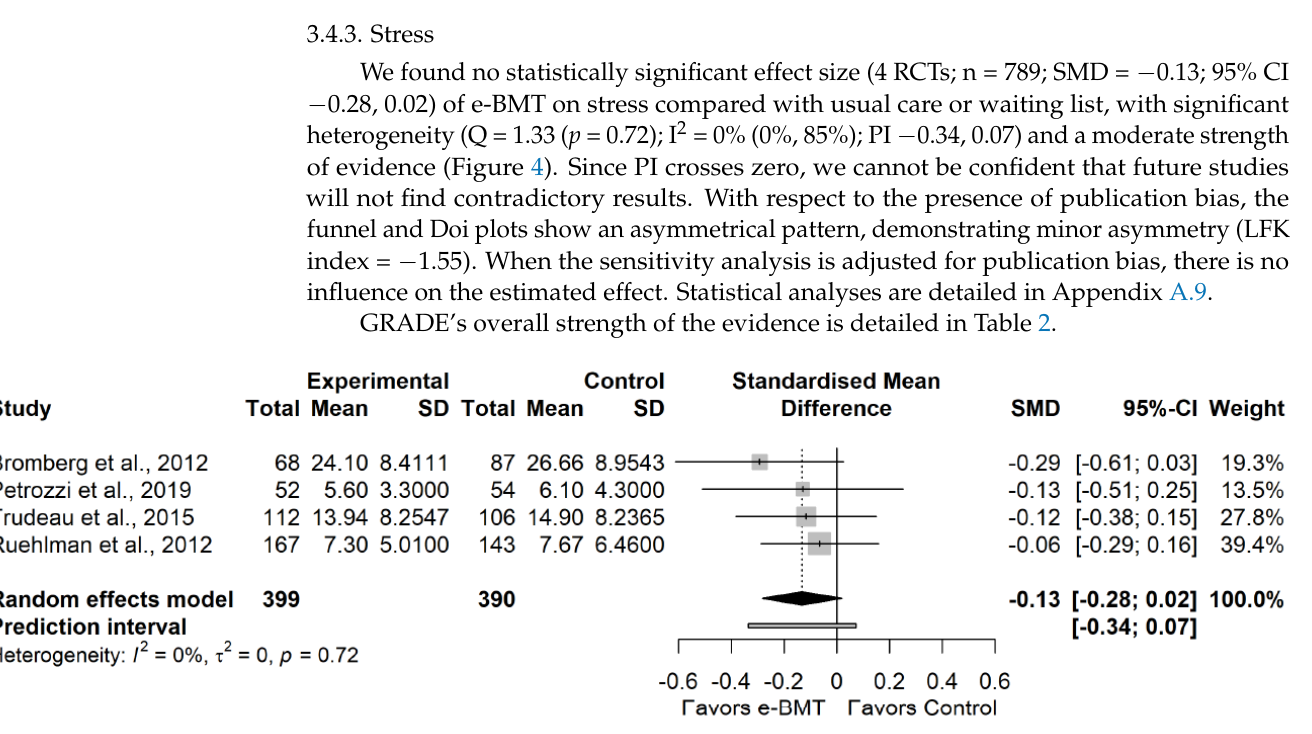
Figure 4. Statistical analysis of the stress variable for telematic behavioral modification techniques against usual care or waiting list. Negative results favor intervention group. The small boxes with the squares represent the point estimate of the effect size and sample size. The lines on either side of the box represent a 95% confidence interval (CI). e-BMT: Telematic Behavioral Modification Techniques. Table 2. GRADE’s overall strength of the evidence .